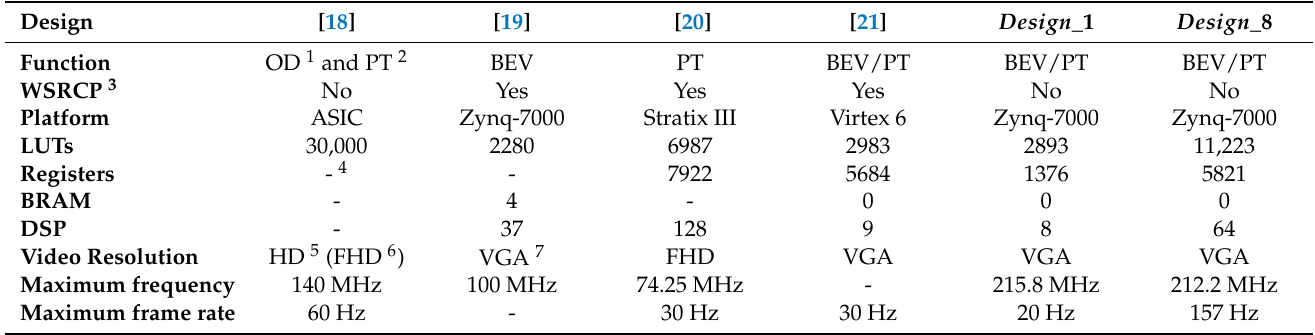
Table 1. Comparison of the performance of different hardware